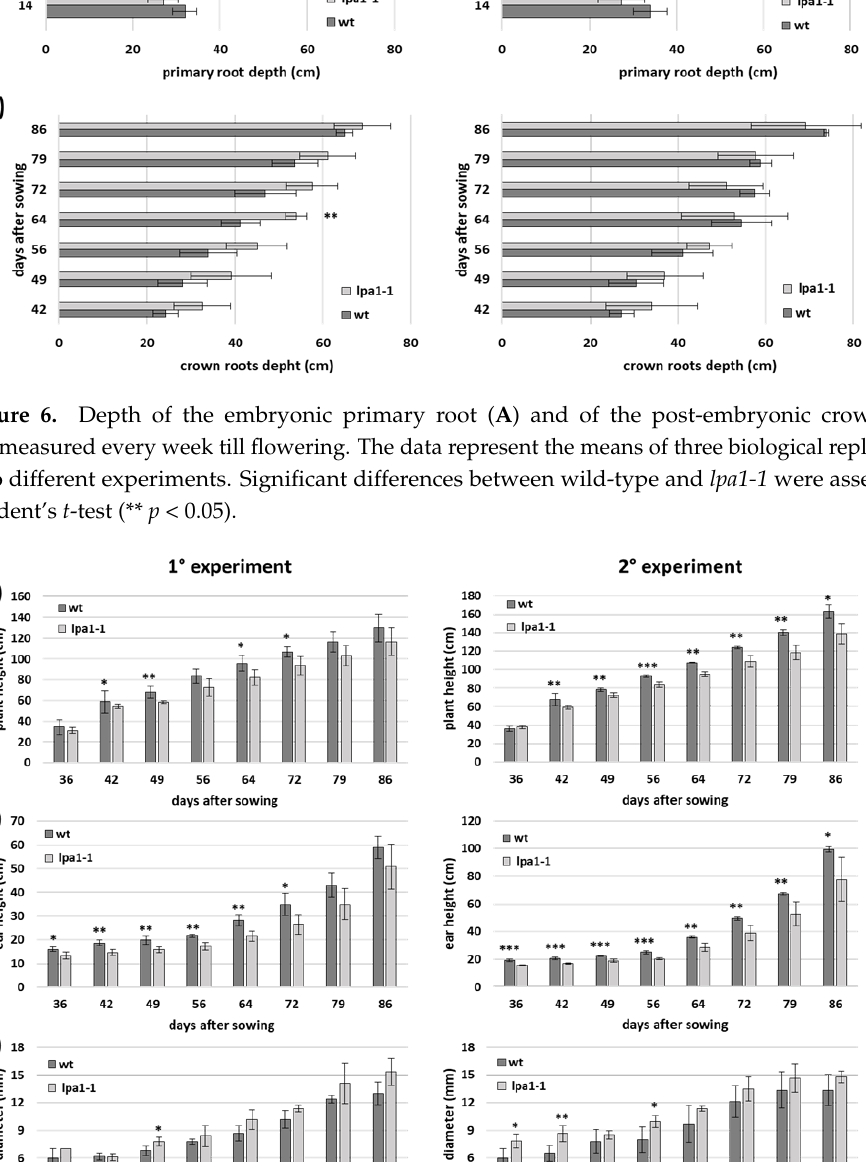
Figure 7. Plant height ( A ), ear height ( B ), and culm diameter ( C ) measured every week till flowering in two different experiments. The data represent the means of three biological replicates. Significant differences between wild-type and lpa1-1 were assessed by Student’s t -test (* p < 0.1, ** p < 0.05, and *** p <